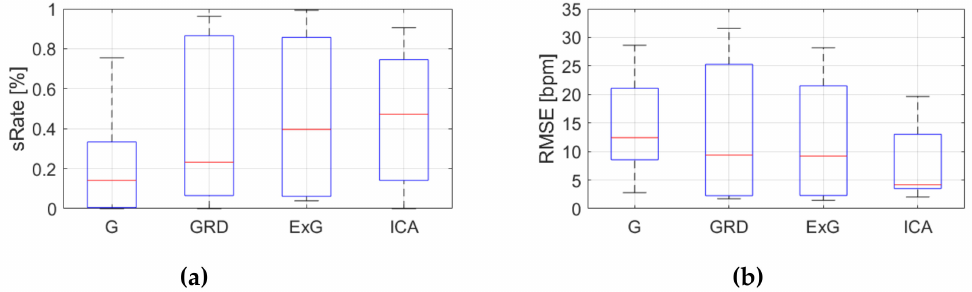
Figure 10. Comparison of signal extraction methods, algorithm No.1 (PSD), part 2: ( a ) box plots for sRate ; ( b ) box plots for RMSE . Blue lines—IQR range, red line—median value.